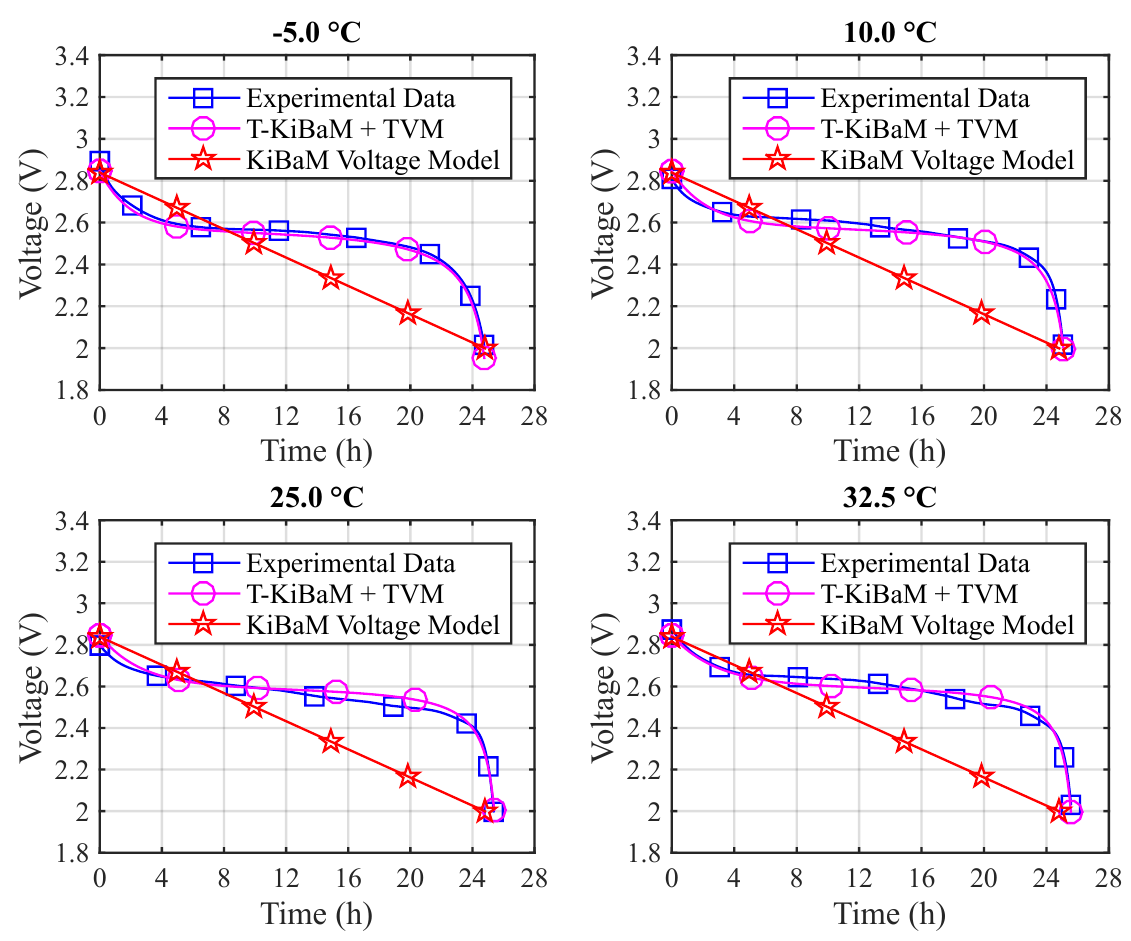
Figure A1. Voltage level tracking